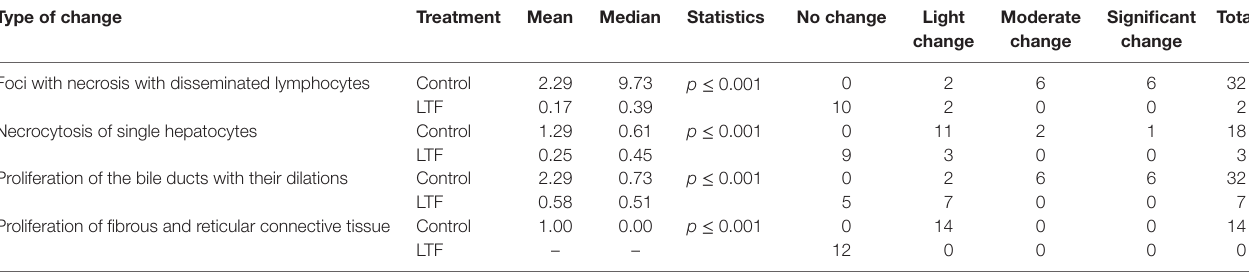
Changes seen in liver tissue samples were scored as none, light, moderate, and significant, as described (108). The non-parametric Mann–Whitney’s test was applied to data, with results given as mean and median values. Significant differences are indicated; n ≥ 12 per group. Data previously published by Zimecki et al. (108).